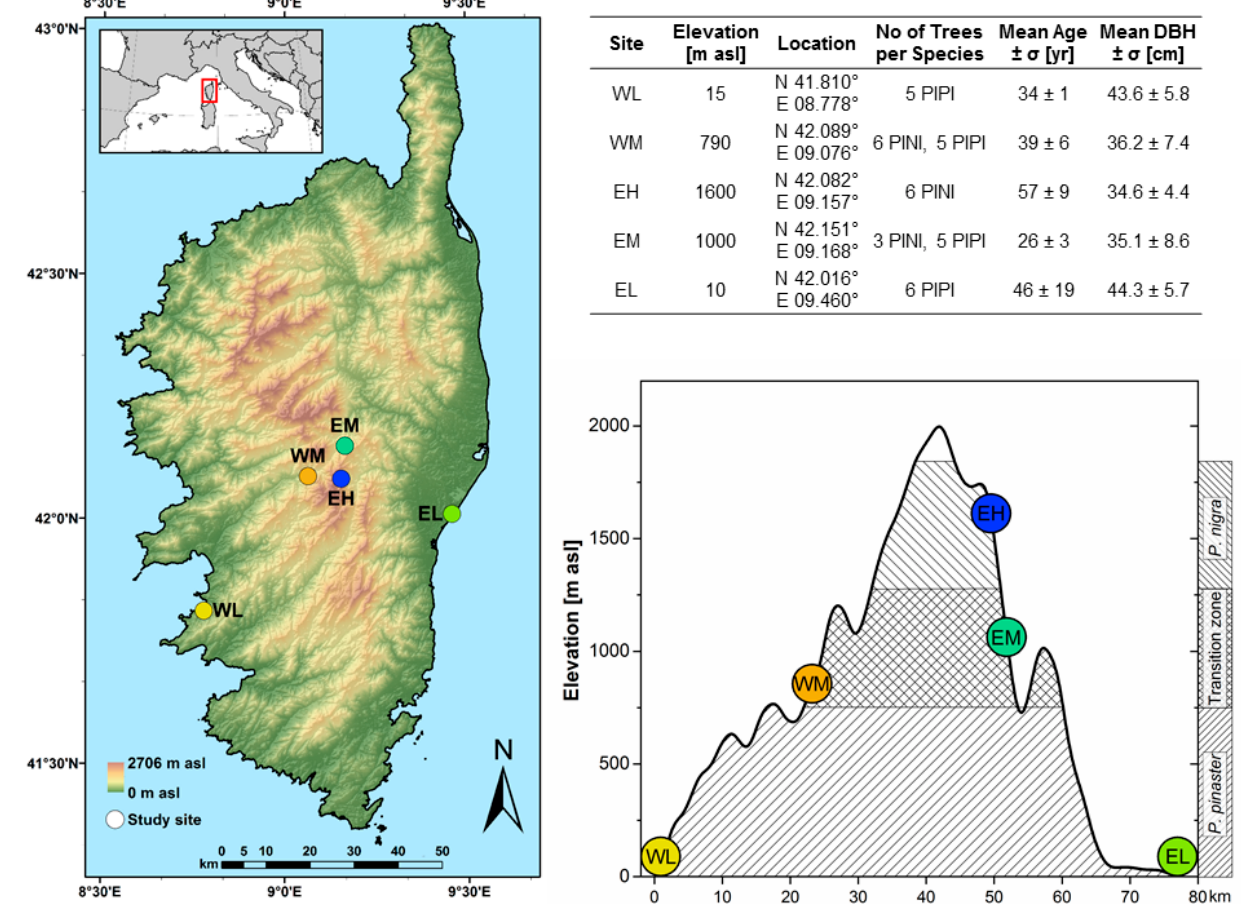
Figure 1. Map with location of study sites. The table contains site details with investigated trees (PINI = Pinus nigra , PIPI = Pinus pinaster , DBH = diameter at breast height). The diagram shows the schematic altitudinal distribution of the species across the east–west transect, including the transition zone, where both species co-occur. Site IDs refer to the respective aspect (W = west and E = east) and elevation (L = low, M = medium, and H = high). σ represents standard deviation.